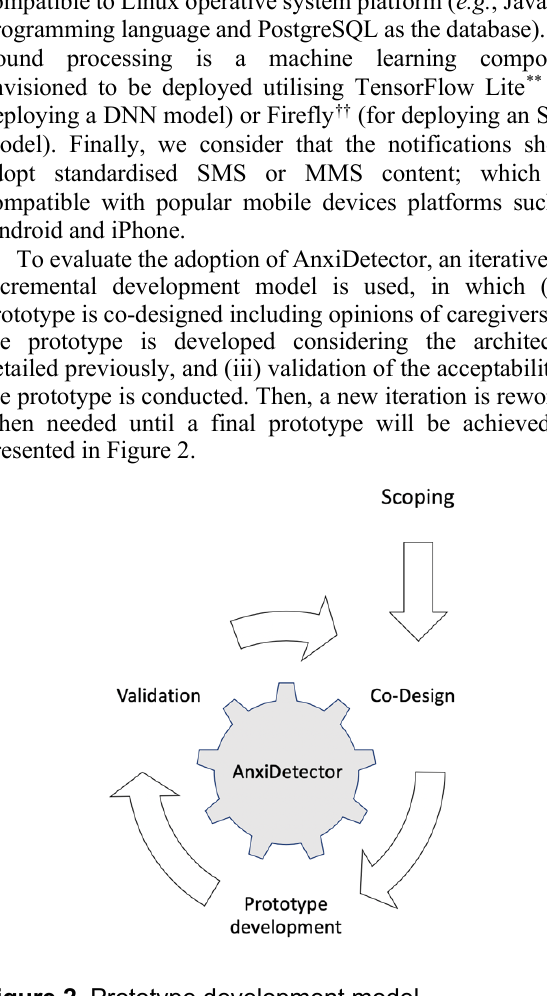
Figure 2 . Prototype development